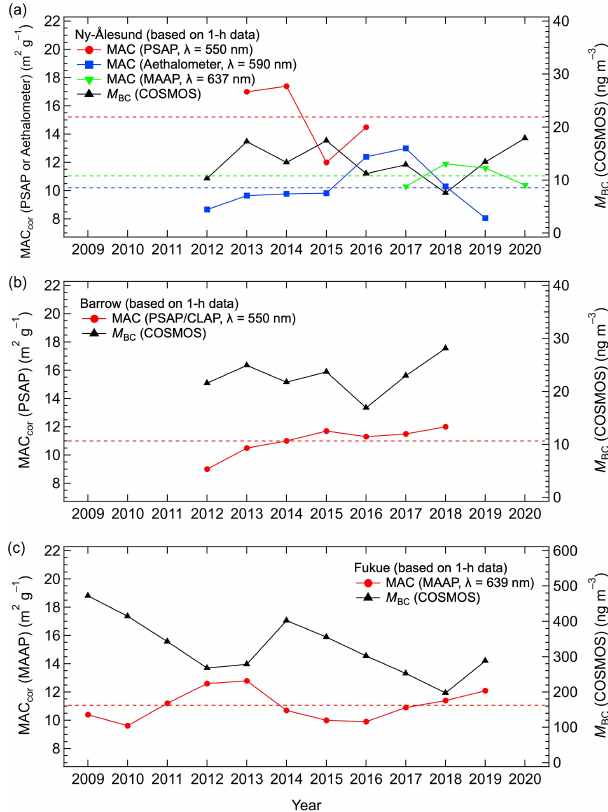
Figure 7. (a) Time series of yearly MAC cor (PSAP; λ = 550nm), MAC cor (Aethalometer; λ = 590nm), MAC cor (MAAP; λ = 637nm), and M BC (COSMOS) at Ny-Ålesund. (b) Time series of yearly MAC cor (PSAP–CLAP; λ = 550nm) and M BC (COSMOS) at Barrow. (c) Time series of yearly MAC cor (MAAP; λ = 639nm) and M BC (COSMOS) at Fukue. In each panel, yearly MAC cor and M BC (COSMOS) are calculated from 1h data. The dashed lines show the averages of yearly MAC cor for the entire time